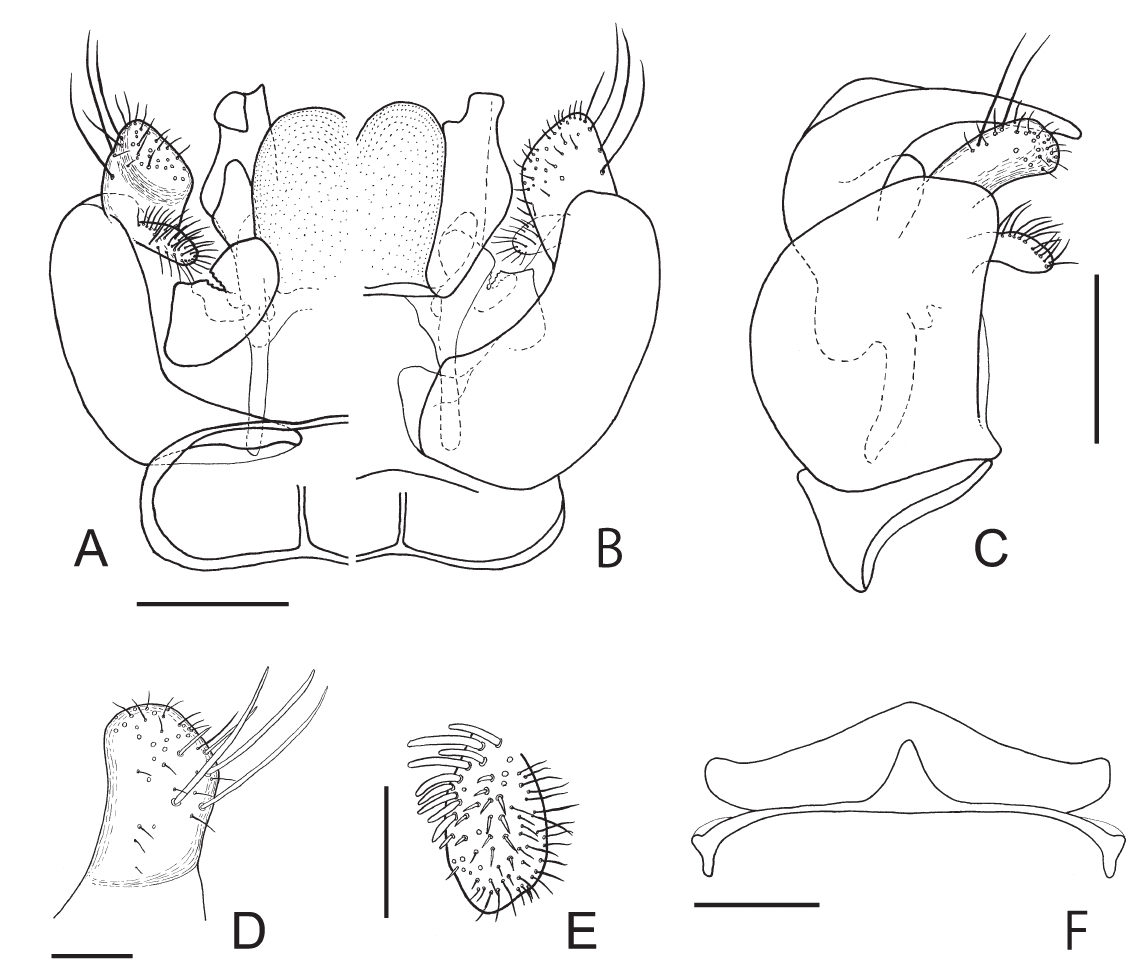
Fig. 11. Lasioglossum ( Dialictus ) taiwanense Murao sp. nov., paratype, ♂. A . Genitalia in ventral view. B . Genitalia in dorsal view. C . Genitalia in lateral view. D . Gonostylus in dorsal view. E . Ventral retrorse lobe of genitalia. F . S7–S8. Scale bars: a–c, F = 0.2 mm, d–e =